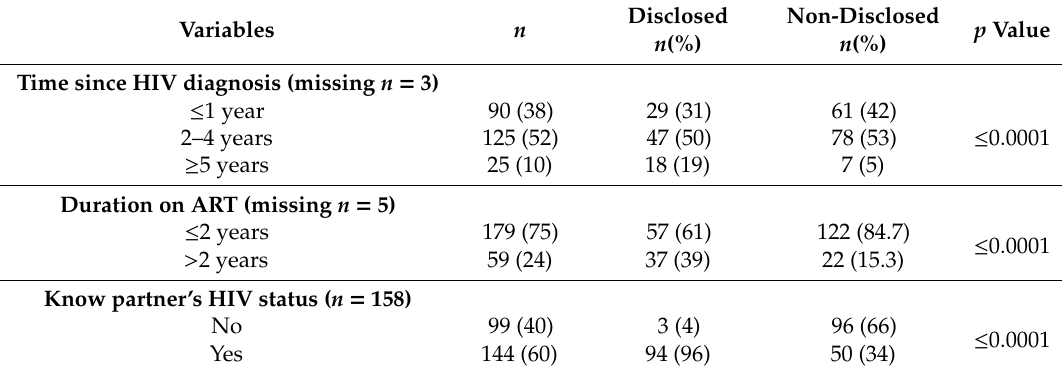
Table 3. HIV clinical data of YPLHIV ( n = 243).